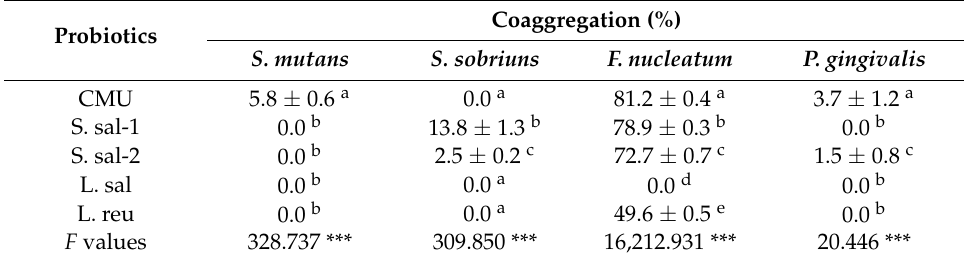
Table 5. Coaggregation of probiotic strains with cariogenic bacteria or periodontopathic bacteria. Probiotics